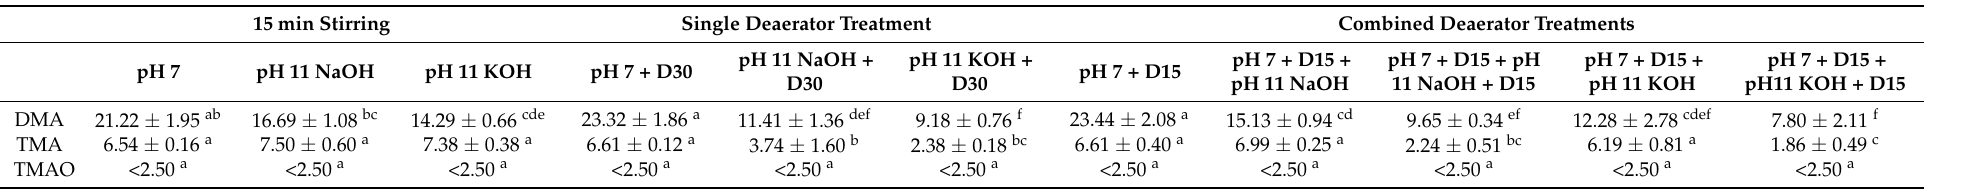
Table 1. DMA, TMA, and TMAO contents of HMH (in parts per million (ppm)) after the 15 min stirring and after the different treatments (mean ± standard deviation).